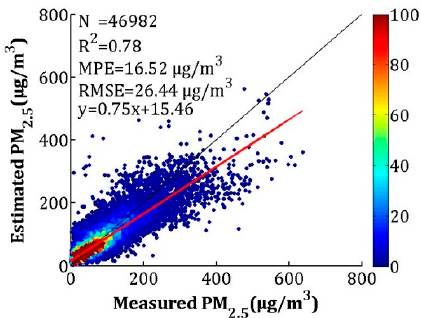
Figure 10. Assessment of overall LME model performance based on measured and estimated PM 2.5 concentrations for cross-validation.